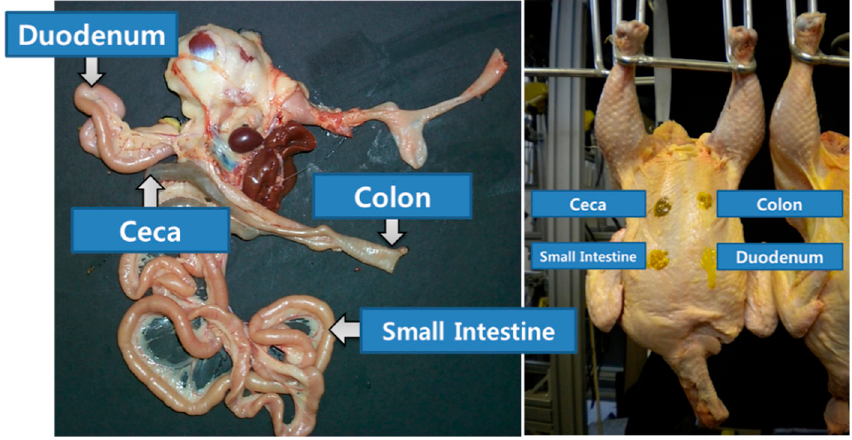
Figure 1. Body substances extracted from the chicken organs such as ceca, colon, small intestine, and duodenum.